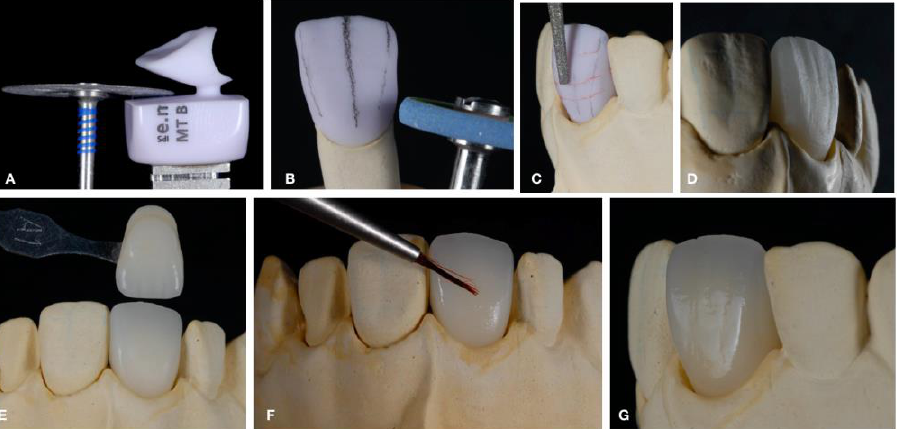
Figure 3. Milled technique. ( A ) Cutting out milled restoration from CAD/CAM block; ( B ) Controlling the margin’s thickness (emergence profile); ( C ) Controlling macro- and micro-texture (finishing); ( D ) After crystallization; ( E ) Stain technique; ( F ) Glaze; ( G ) Final restoration.